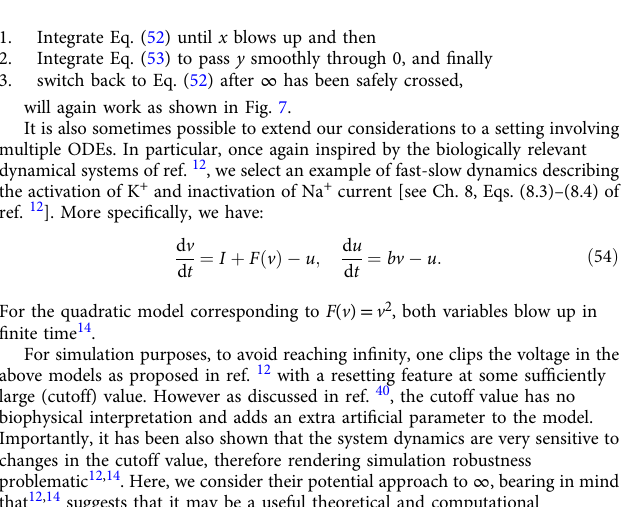
Fig. 9 Passing in fi nity numerically for the 2D quartic integrate-and- fi re model. Repeatedly: a integrate Eq. (54) until ν , blows up, b the adaptation variable u remains bounded, c integrate the transformed system to pass smoothly through 0. Here we show the dynamics of the singular transformation y = 1/ ν 3 . For our simulations, we have set b = 1, I = 1, initial conditions ν (0) = 1, u (0) = 0.1; time integration was performed using the ode23s matlab solver 55 with relative tolerance = 1. E − 08 and absolute tolerance = 1. E −